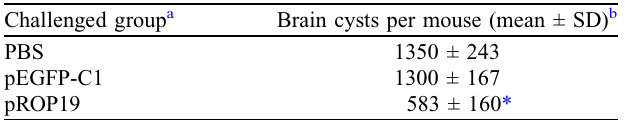
Table 4. Cysts in injected mice after challenge by cysts of PRU strain.